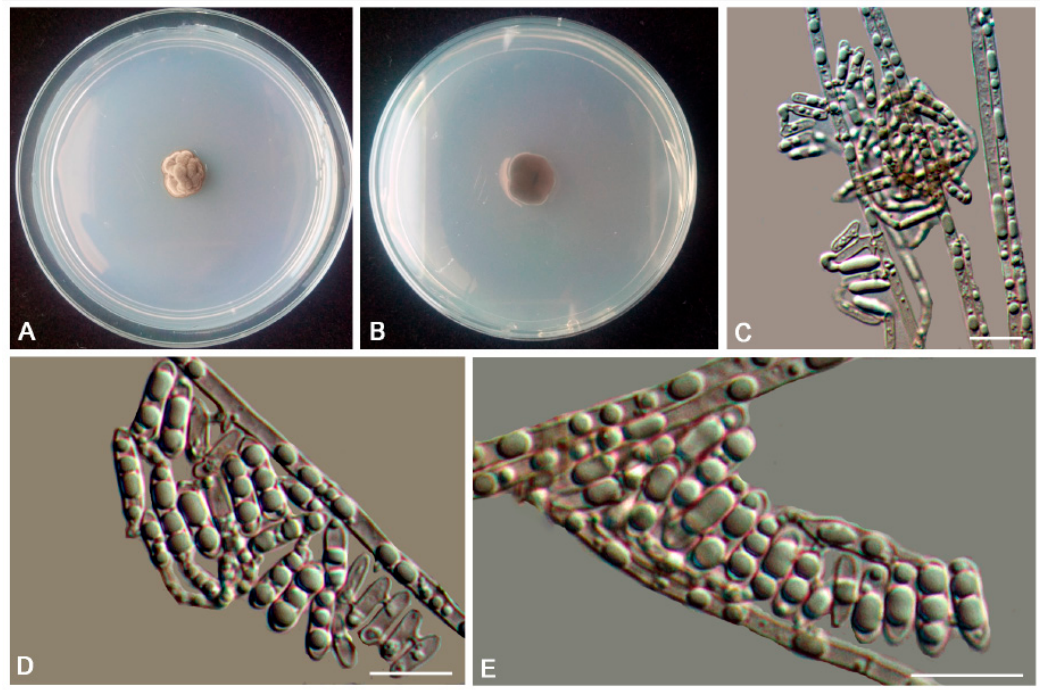
Figure 20. Exophiala clavispora (CGMCC 3.17517). ( A , B ) Forward and reverse of colony on MEA. ( C )